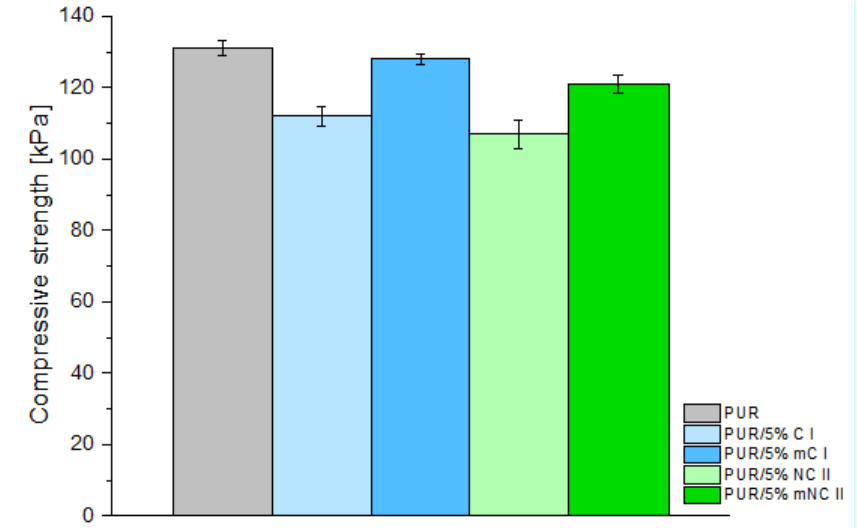
Figure 7. Water absorption of composites depending on filler type (5% loading).